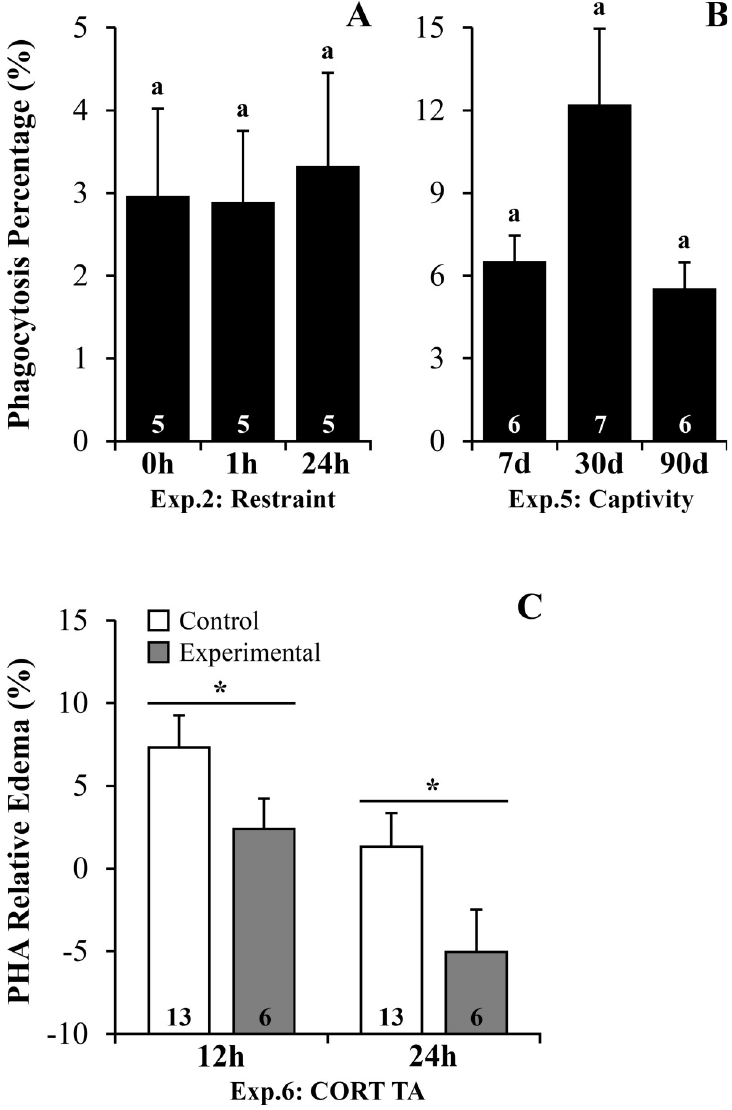
Fig 4. Phagocytosis activity and inflammatory response following stressors and corticosterone transdermal application in R . ornata toads. (A) Experiment 2: Restraint– 0h vs . 1h vs . 24h. (B) Experiment 5: Captivity– 7 vs . 30 vs . 90 days. Phytohemagglutinin relative edema. (C) after 12 and 24h post PHA injection at the end of Experiment 6: Corticosterone transdermal application. Bars represent mean ± standard error. The N is indicated inside each bar. Letters above the bars represent statistical differences for Bonferroni adjustments in ANOVAs, with different letters representing statistical difference within groups with P � 0.05. The asterisks represent ANCOVA statistical differences ( P � 0.05) between treatment groups (control vs . experimental) at each specific time (12 or 24h). Abbreviation: Exp.: Experiment; CORT TA: Corticosterone transdermal application; PHA: Phytohemagglutinin. Legend: Control: control and placebo group; Experimental: corticosterone